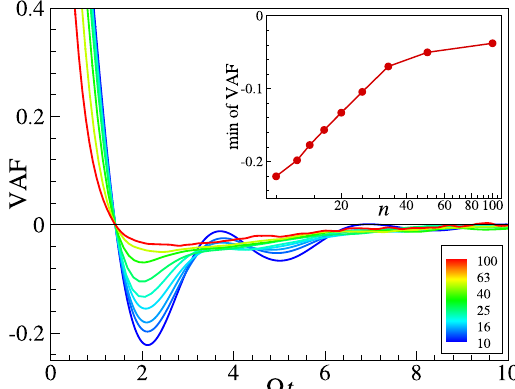
Figure 4. Velocity autocorrelation functions (VAF) of the IPL melts when increasing the exponent n from  n 10 to  n 100 (curves are color-coded correspondingly). The time is normalized in such a way, that all VAF curves intersect zero at the same point, Ω is roughly the Einstein frequency 3 . The inset shows the dependence of the minimum value of VAF on the IPL exponent n , revealing the saturation-like behavior at large n .